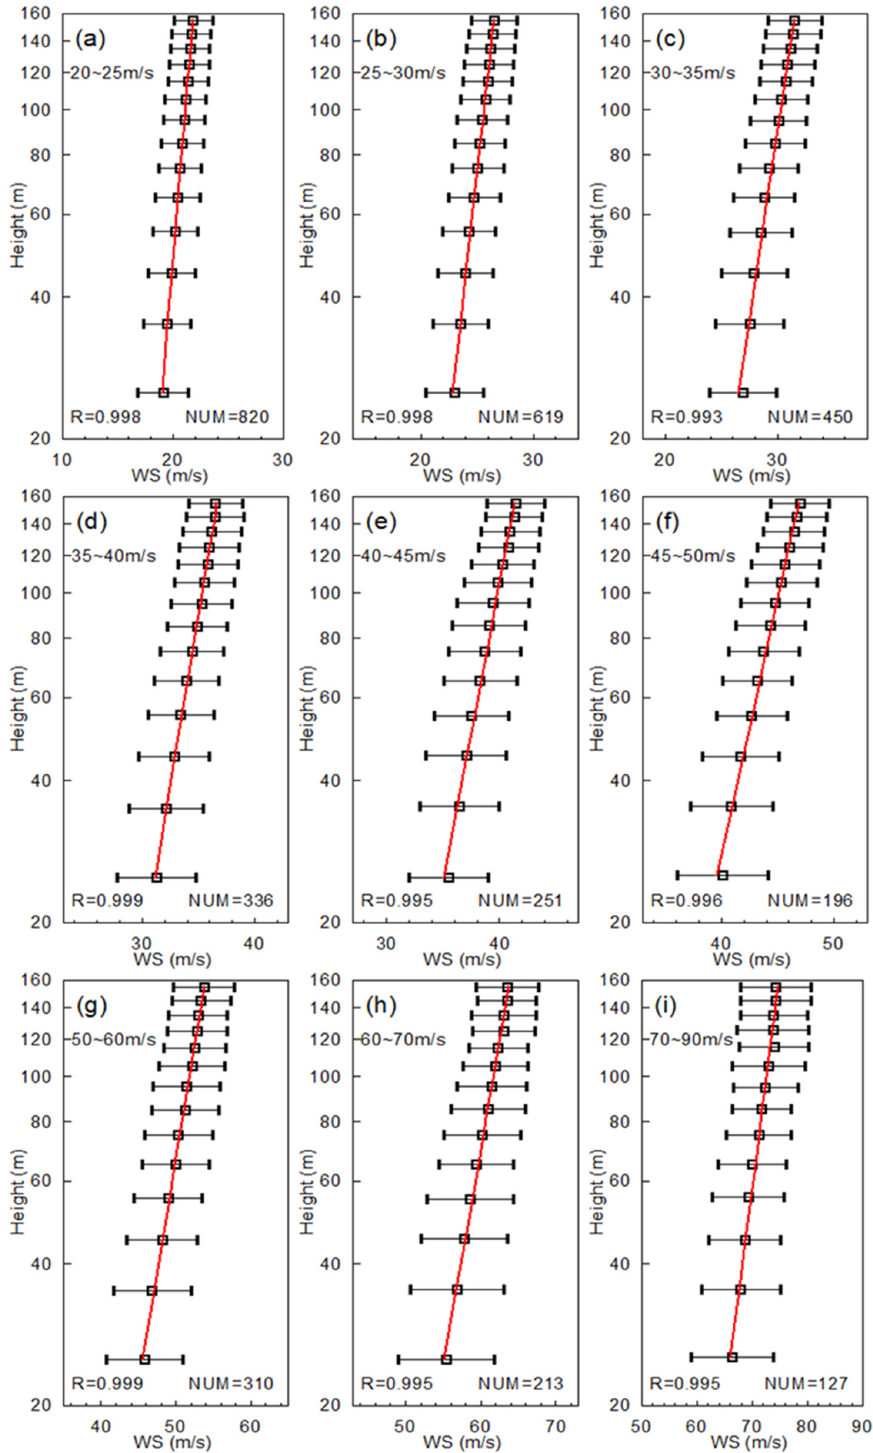
Figure 2. Wind profiles of each MBL mean wind speed group between 20 and 90 m s − 1 : ( a ) 20–25 m s − 1 ,